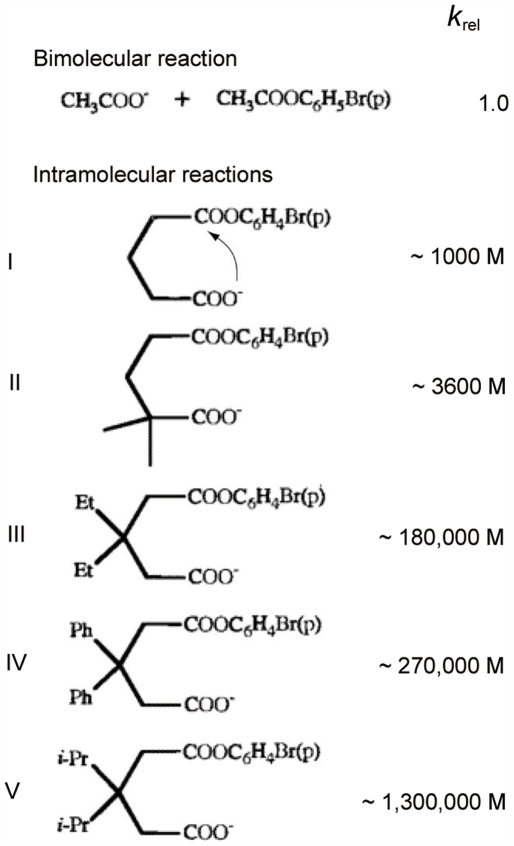
Effect of the local environment on a reaction rate.Relative reaction rates (k
rel) of a bimolecular reaction and some corresponding intramolecular reactions. In the intramolecular systems, the nucleophilic attack (indicated by a small arrow in compound I) leads to the cyclization of the compounds. Adapted from ref. [12].